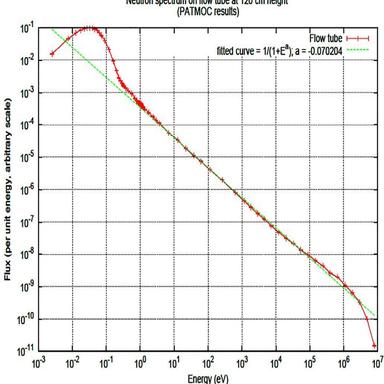
Neutron energy spectrum generated by code PATMOC.